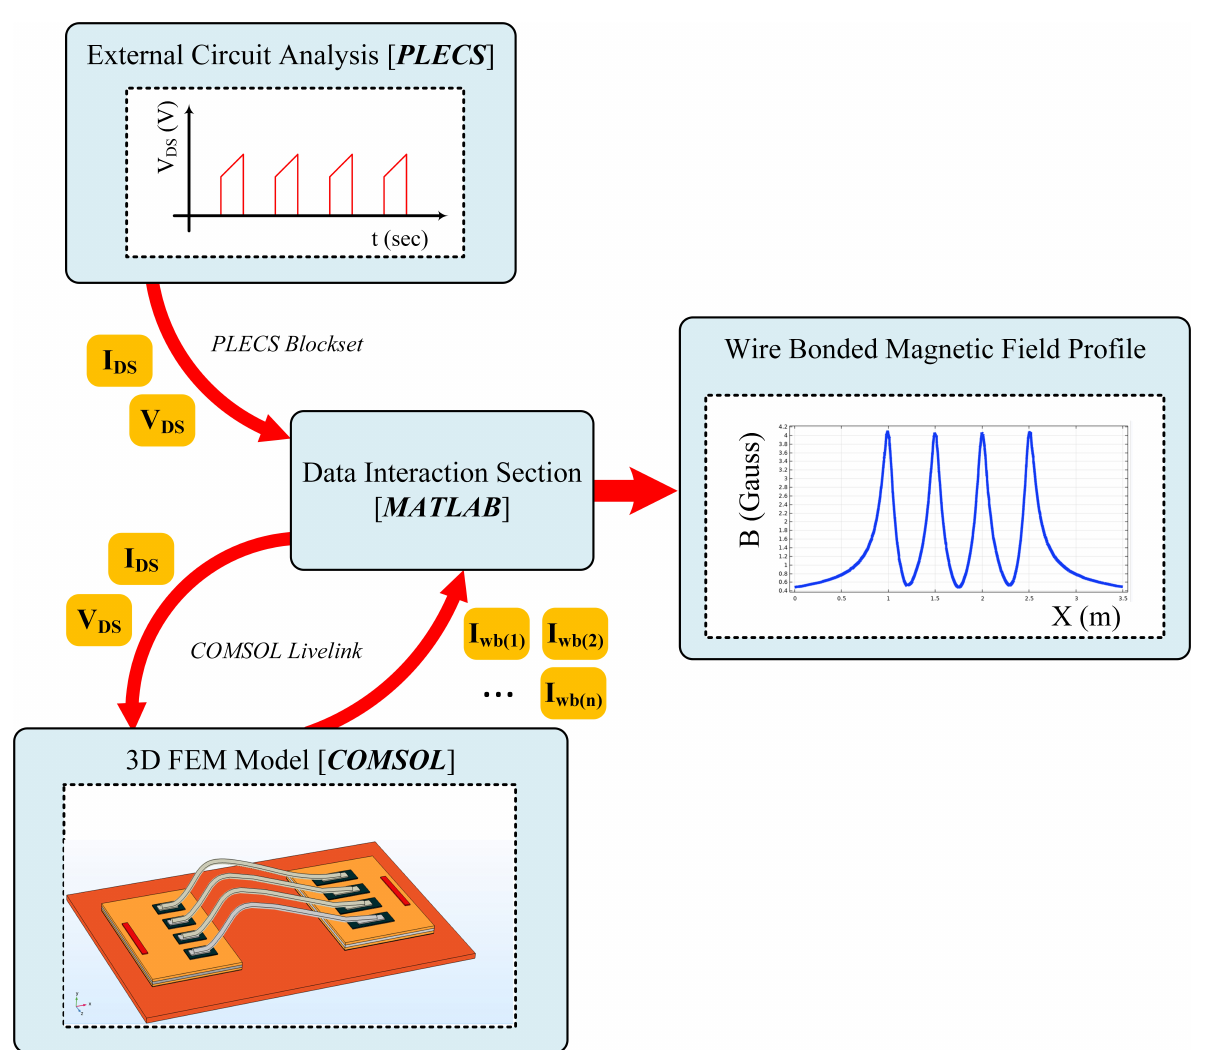
Figure 4. Developed simulation platform and the data interaction between the three main